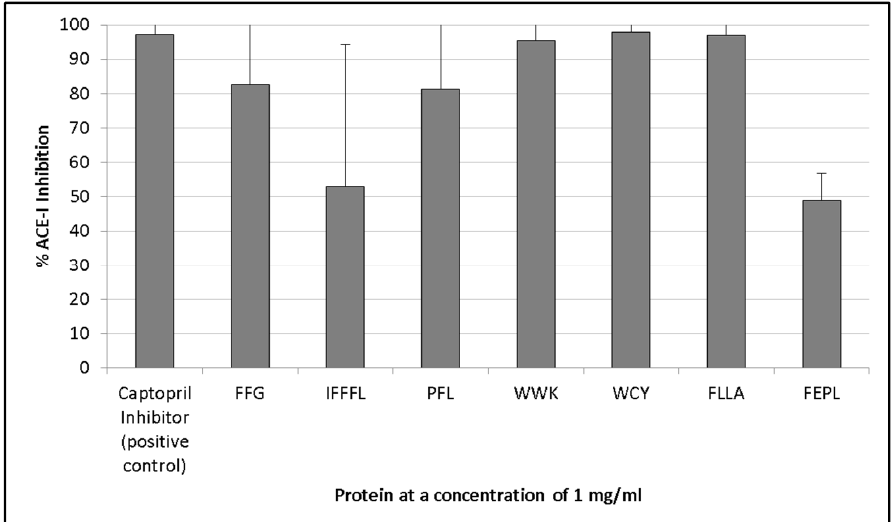
Figure 4. ACE ‐ I inhibition assay of several synthesised peptides that were identified in silico from the digestion of oat proteins with papain or ficin, which are both proteases. The activity of peptides was compared with that of a captopril inhibitor (positive control). Peptides were assayed at a concentration of 1 mg protein of extract/mL. Values are the mean of triplicate samples. Foods 2017 , 6 , 108